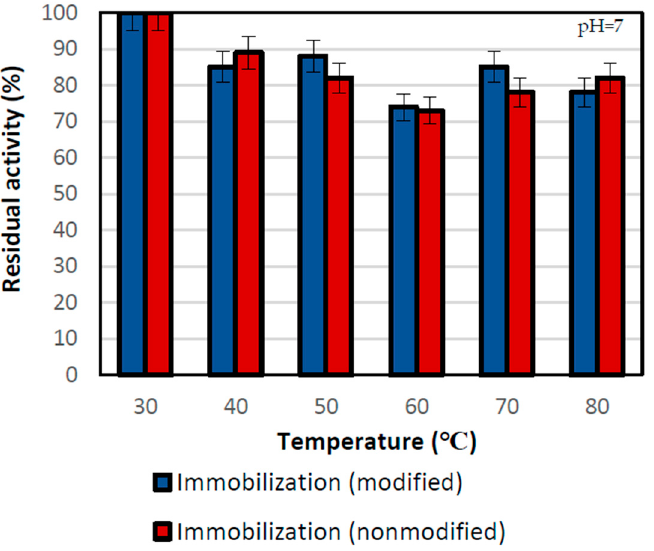
Figure 4. Thermal stability of lipase immobilized by two physical techniques: by the adsorption interactions and partially interfacial activation and mixed physical immobilization via interfacial activation and ion exchange. All experiments were performed in duplicate and the results presented in each of the graphs are presented as a mean value with standard deviation (error value). The thermal stability test was performed in the 100 mM phosphate buffer at pH 7 in different temperatures.